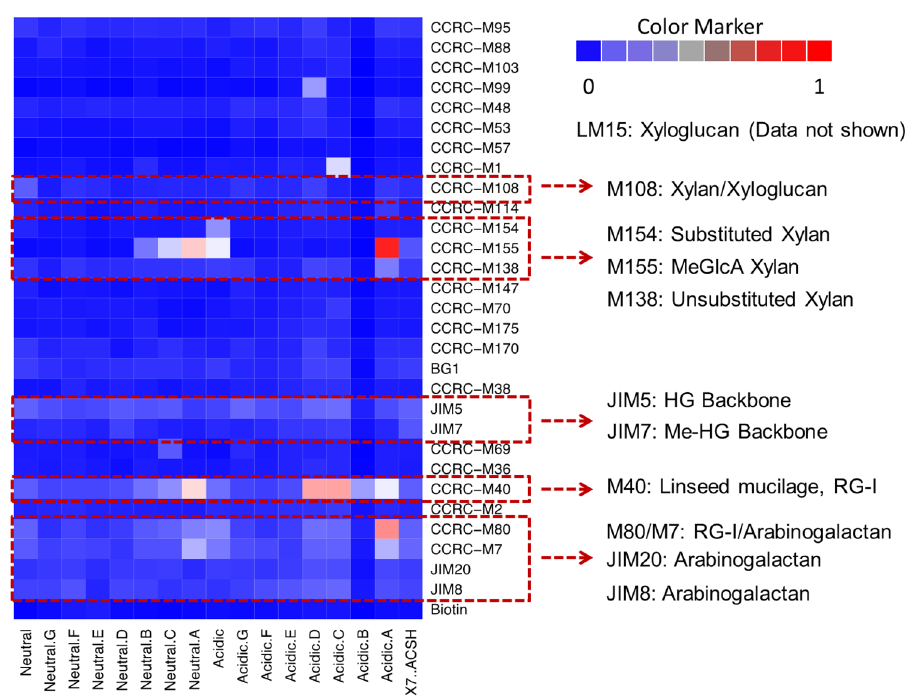
Figure 3. Recalcitrant oligosaccharides epitopes being detected using cell wall glycan-directed monoclonal antibodies. ‘Neutral’ fractions are the ACN fractions and ‘Acidic’ fractions are the FA fractions. Brighter red color in the heat map indicated higher abundance of epitope and brighter blue color indicate blank background. The color value on the scale is based on raw OD values of N = 2 preparations. Major epitopes recognized by antibodies are given on the right-hand